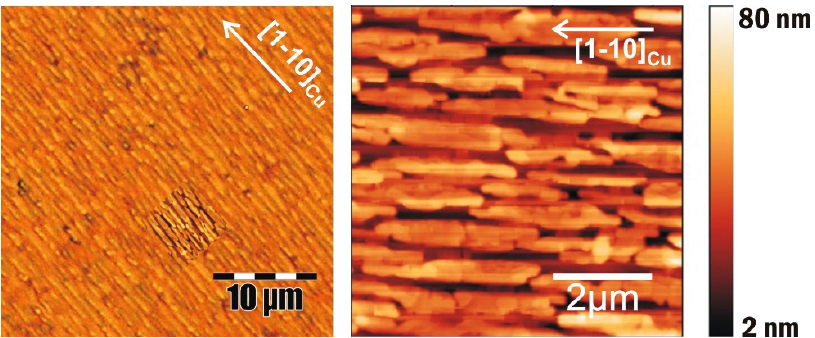
Figure 1. Microscopy images of a 30-nm-thick quinquephenyl film prepared on a Cu(110)-(2 × 1)O surface: light microscopy ( left ) and atomic force microscopy ( right ). The [1–10] Cu directions along the substrate surface are given by arrows.